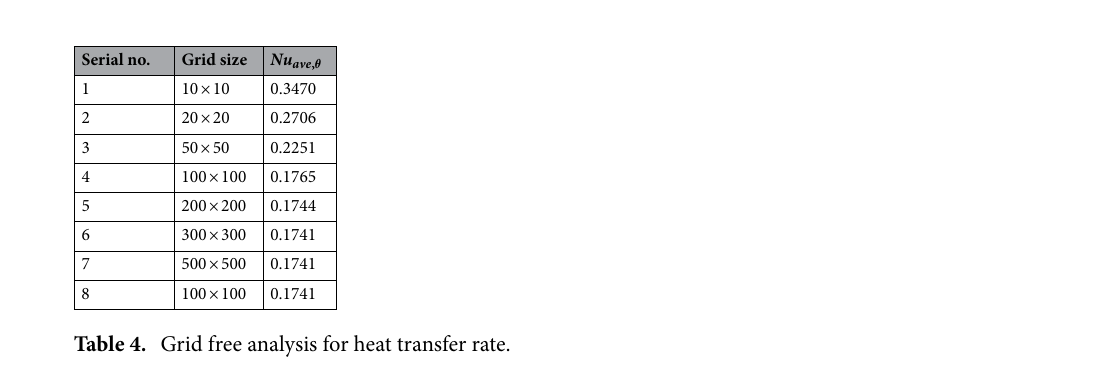
Table 4. Grid free analysis for heat transfer rate.